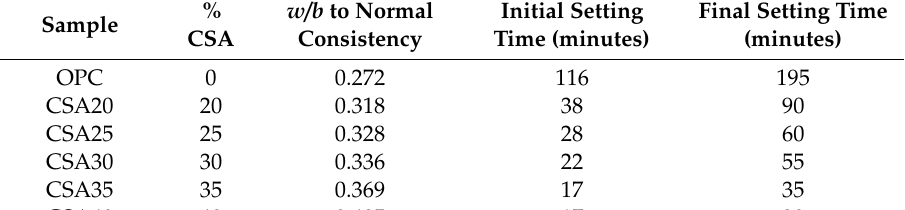
Table 4. Water to binder ratios ( w / b ) to normal consistency and setting times of cement pastes.